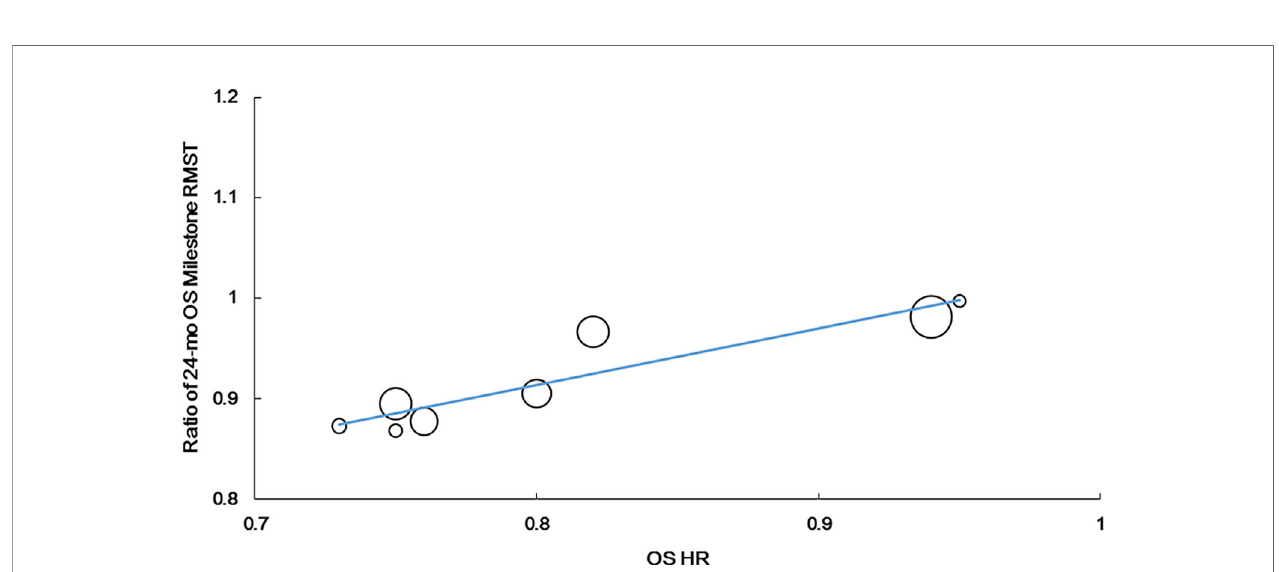
FIGURE 4 | Correlation of treatment effects on the overall survival (OS) hazard ratio (HR) with the ratios of 24-month OS milestone RMST.